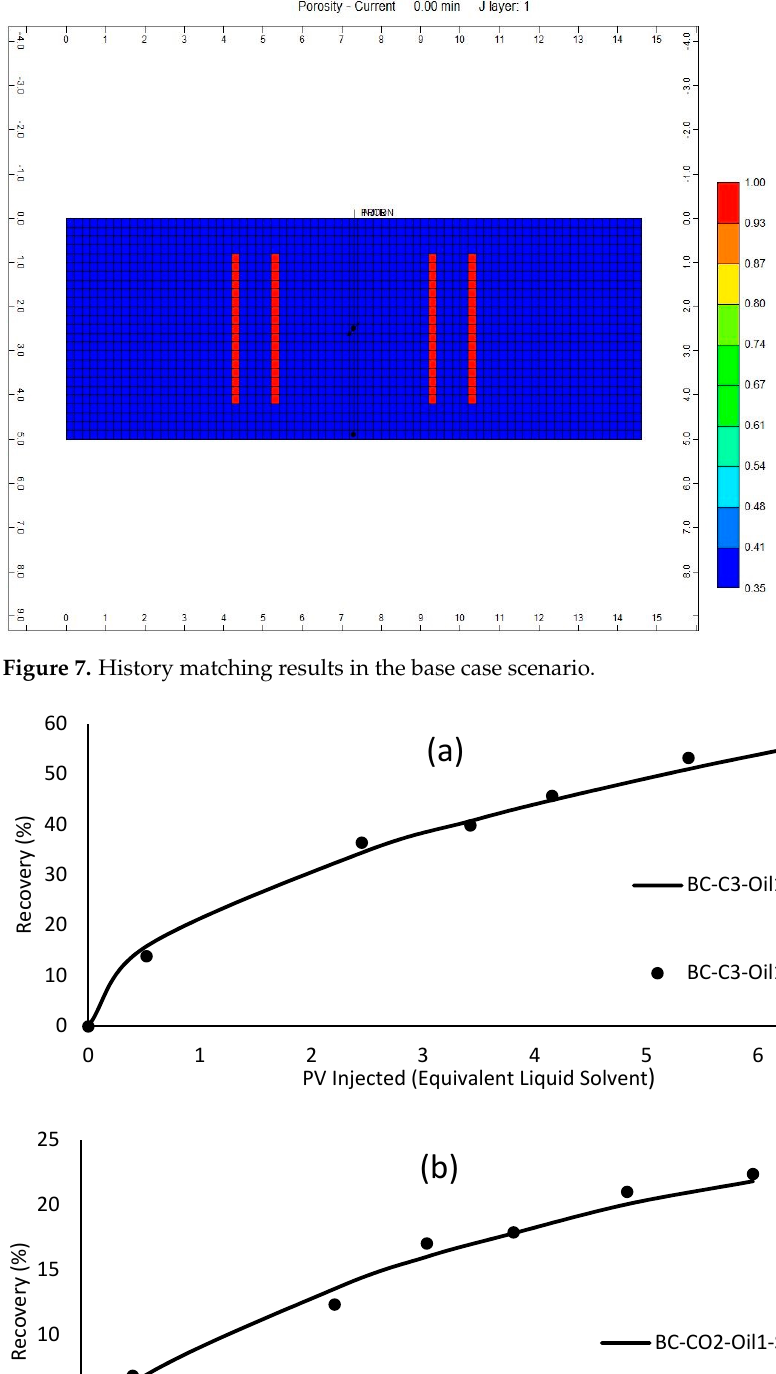
3 H 8 , and ( b ) CO 2